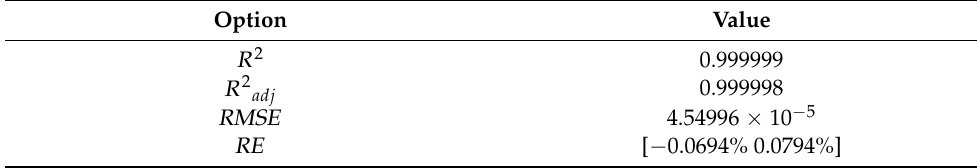
Table 6. Accuracy of the RS model for the membrane